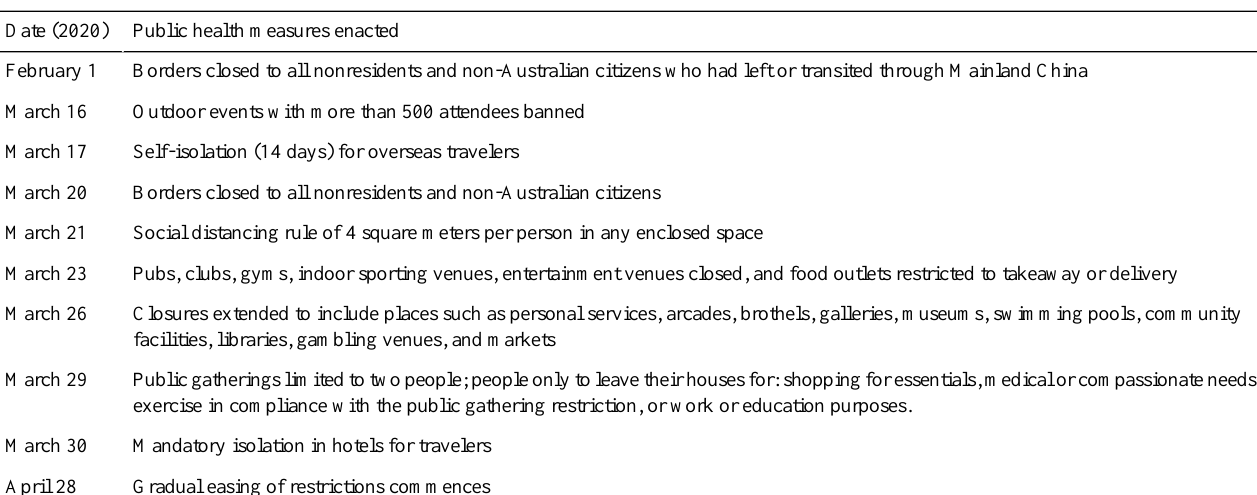
Table 3. Coronavirus disease public health measures enacted in the state of New South Wales, Australia, February 1 to April 30,